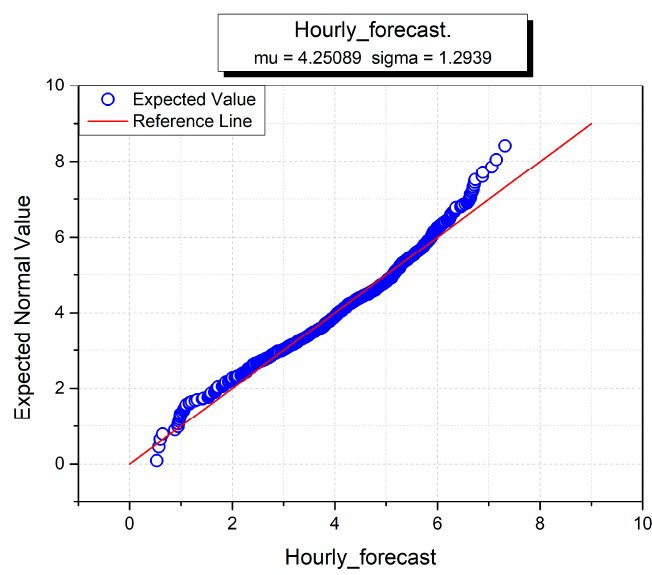
Energies 2019 , 12 , x FOR PEER REVIEW Figure 15. Hourly normal distribution for wind power forecasting. Figure 15. Hourly normal distribution for wind power forecasting.